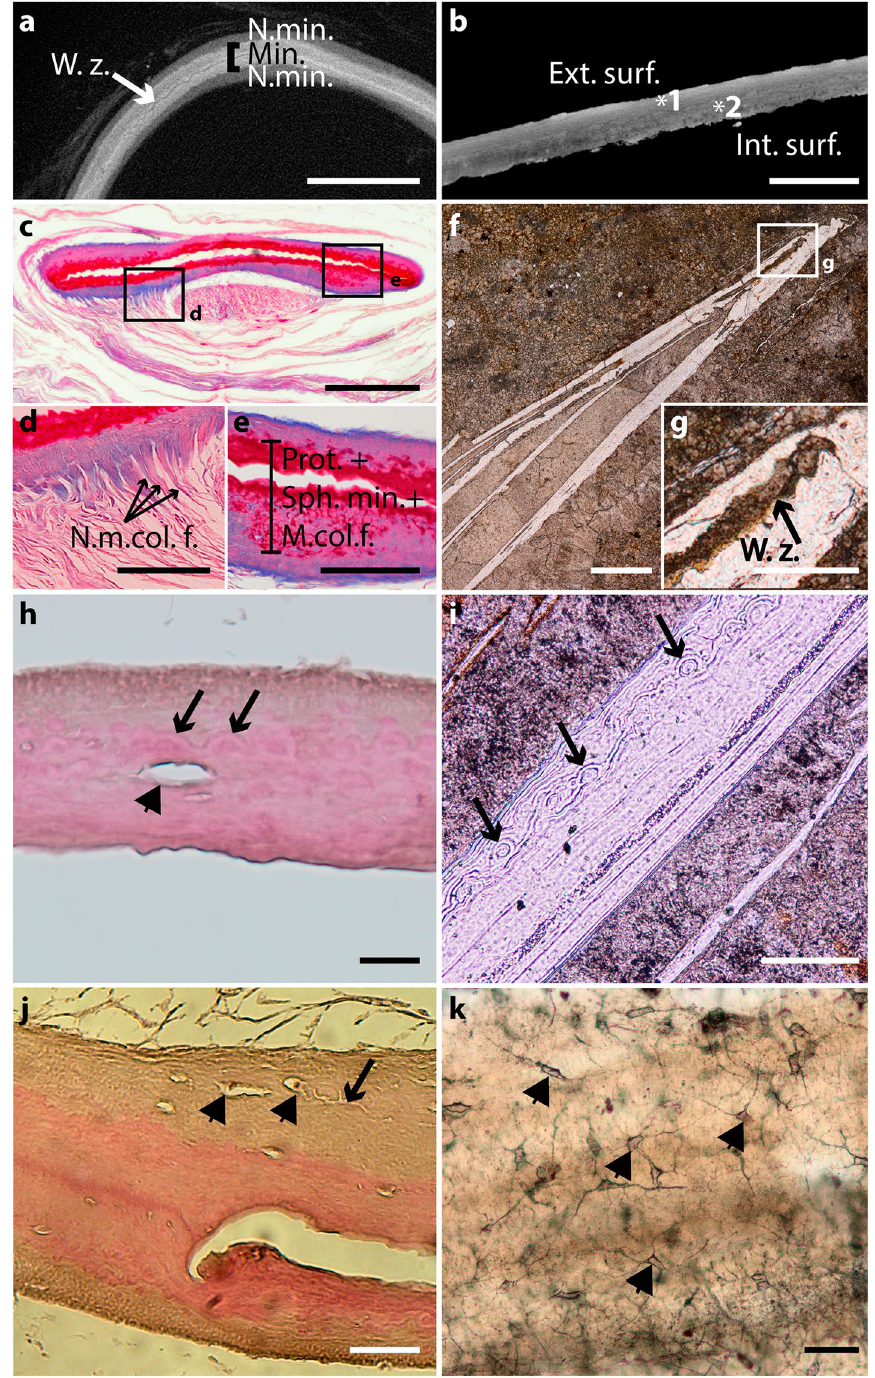
Figure 2. Extant and fossil coelacanth lung plates. ( a ) Virtual transverse section of an ossified plate of the extant coelacanth Latimeria chalumnae (adult specimen CCC 24). ( b ) Virtual section of an ossified plate of the fossil coelacanth Axelrodichthys araripensis from the Lower Cretaceous of the Santana Formation, Araripe Basin, Brazil (‘Josa collection’ MNHN, Paris); asterisk 1, external surface; asterisk 2, internal surface. ( c ) Histological thin section of a Latimeria chalumnae lung plate (adult specimen CCC 5, azocarmin coloration). ( d ) Close-up of boxed area in ( c ), focussing on collagen fibres at the extremity of the plate, which corresponds to the non- mineralised region. ( e ) Close-up of boxed area in ( c ), focussing on mineralised portion of the plate comprising proteoglycans, collagenous fibres, and spheritic mineralisation. ( f ) Ground cross-thin section of Axelrodichthys araripensis (UERJ-PMB 143) lung plate showing central artefactual fracture. ( g ) Close-up of boxed area in ( f ), focussing on weakness zone. ( h ) Histological thin section of a Latimeria chalumnae lung plate (haematoxylin/ eosin coloration, adult specimen CCC 24); black arrows point to mineralised globules with a radiating arrangement; arrowhead points to osteocyte lacunae. ( i ) Ground cross-thin section of Axelrodichthys